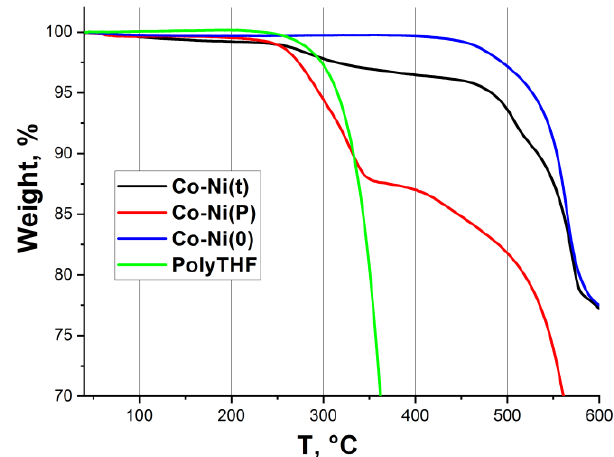
Figure 1. Thermogravimetry (TG) curves for the Co-Ni complexes used in this work and for poly(tetrahydrofuran) (poly(THF)).